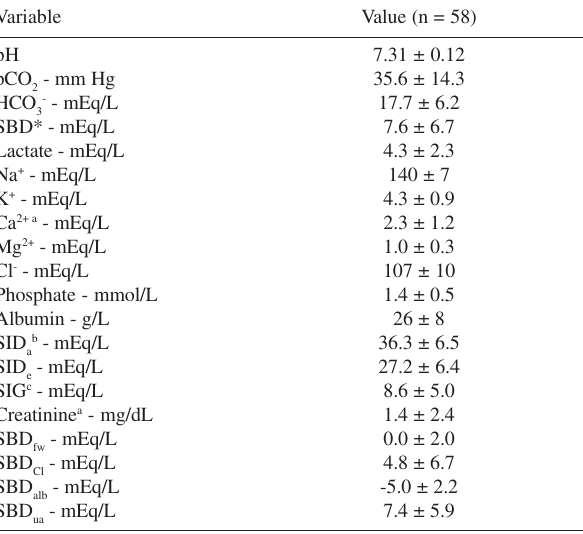
Table 2 - Biochemical variables of the 58 patients with hyperlactatemia (lactate ≥ 2 mEq/L) (mean ± SD) Variable